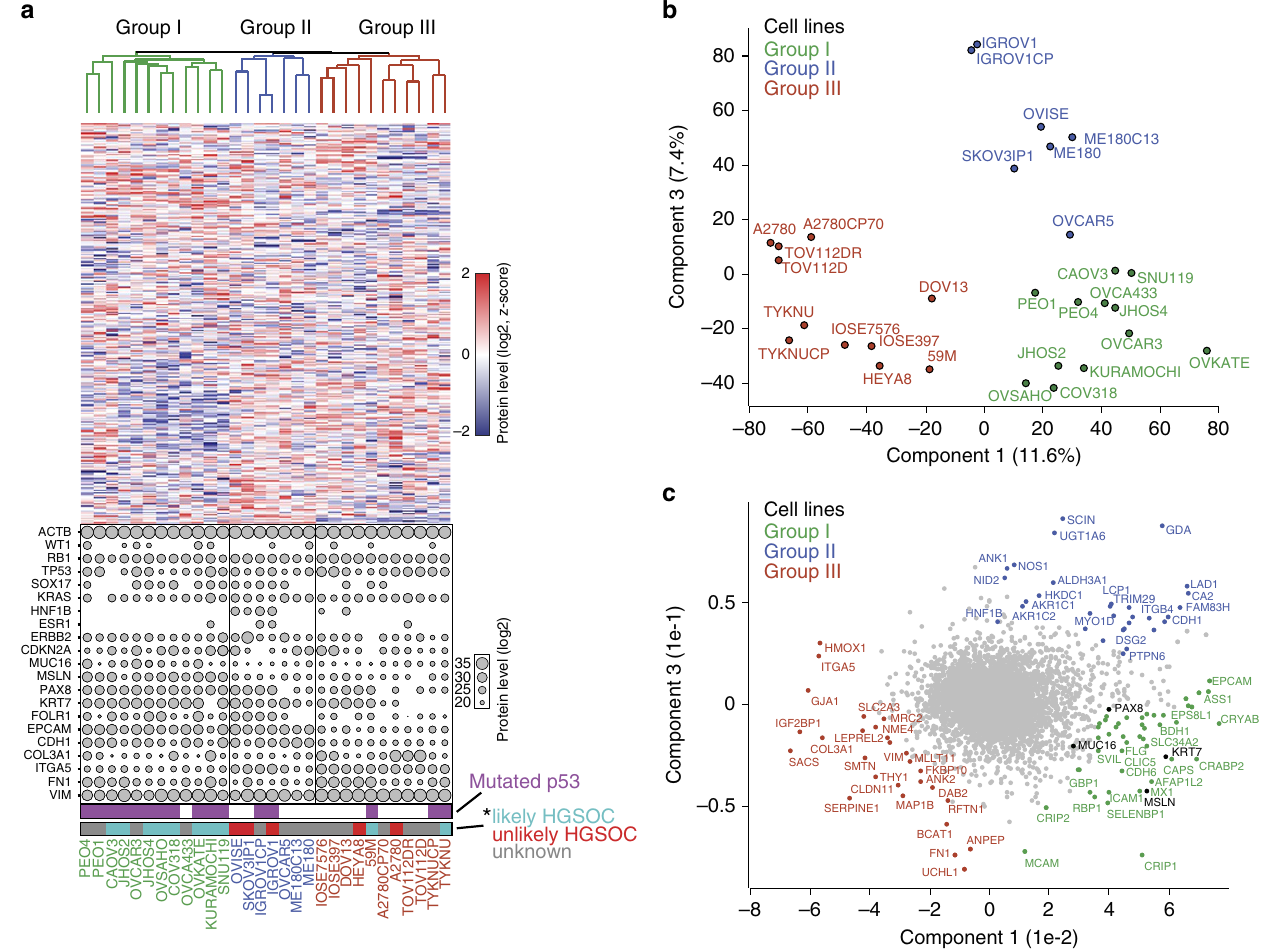
Figure 3 | Proteomic clustering reveals three distinct cell line groups. ( a ) Unsupervised hierarchical clustering was carried out on the basis of the relative expression of 8,487 proteins, delineating three major cell line groups (group I, green; group II, blue; group III, red). The relative expression levels of 15 frequently altered proteins in OvCa are plotted for each of the 30 cell lines. Levels of known OvCa-related proteins (VIM, FN1, EPCAM, CDH1 and CDKN2A) are also plotted. Relative protein levels are depicted by circle size. Relative ACTB levels are included for reference. * ‘likely HGSOC’ (teal) and ‘unlikely HGSOC’ (red) refer to the descriptions of these cell lines based on their genomic profiles as reported by Domcke et al. 9 ; ‘unknown’ cell lines in grey were not analysed in that study. ( b ) The presence of three major cell line groups was confirmed by principal component analysis (PCA) of the 30 cell lines. ( c ) Proteins driving the PCA separation. The driver proteins from the three groups are identified on the PCA. Known HGSOC proteins MUC16, PAX8, KRT7 and MSLN are highlighted in